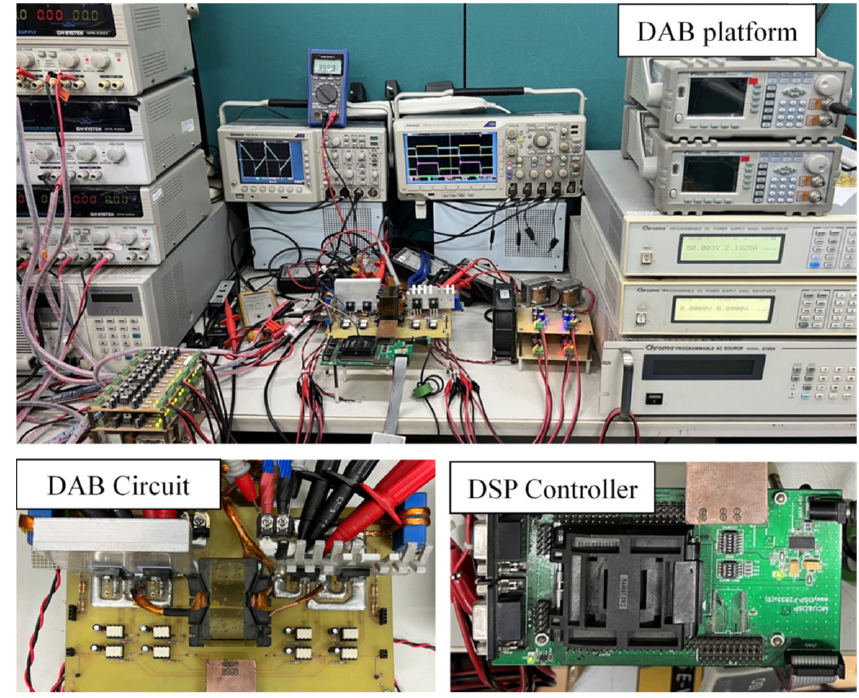
Figure 11. Experimental platform of DAB in laboratory. Table 3. Specifications of the proposed DAB converter